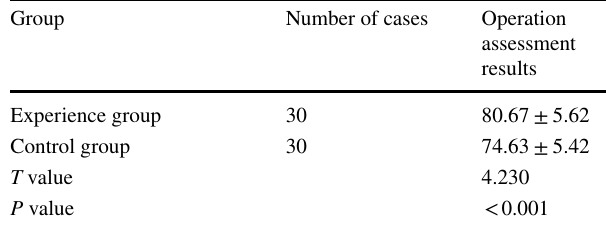
Table 4 Comparison of two groups of interns' scores in